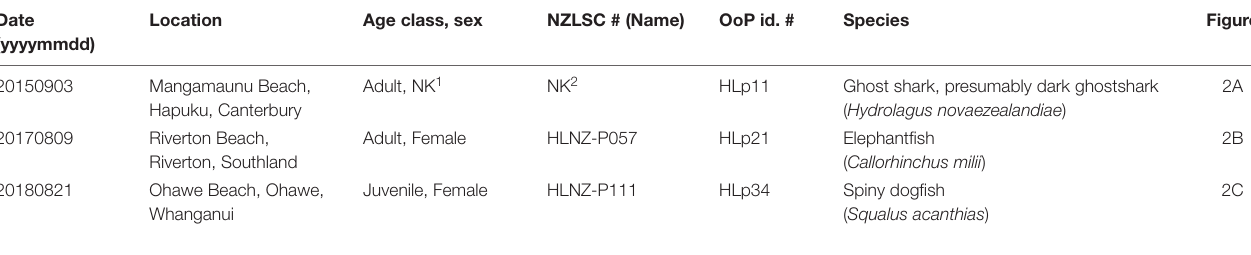
TABLE 4 | Observations of leopard seals ( Hydrurga leptonyx ) predating on chondrichthyans in New Zealand waters, where the prey was found intact. Date (yyyymmdd)